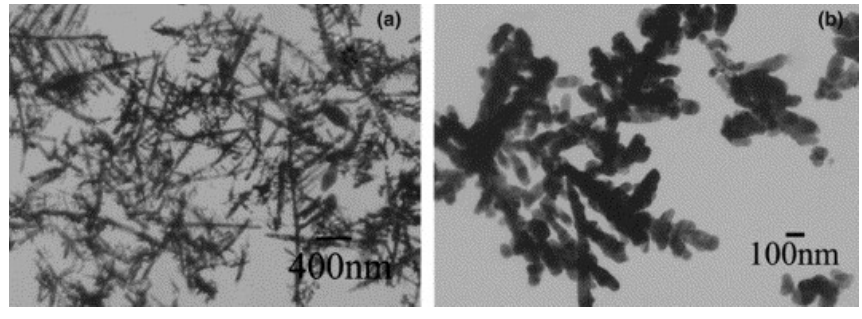
Figure 4. Silver nanoparticles prepared (a) without PVP and (b) 0.1 g/l PVP. Reprinted from ref [49] with permission from